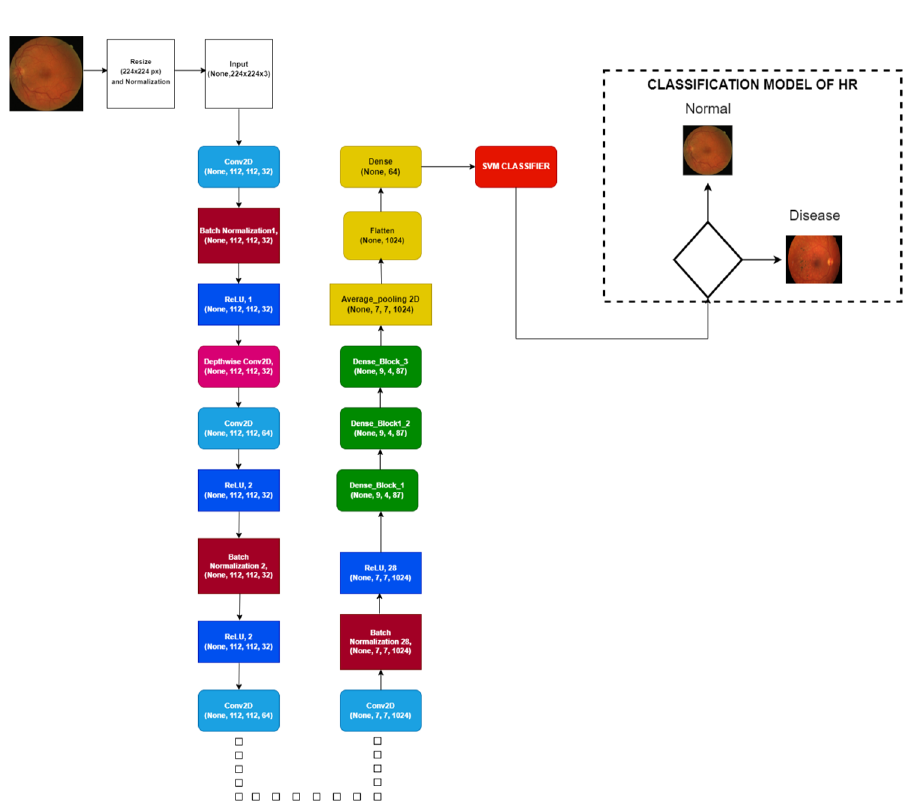
Figure 8. Complete proposed architecture of the Mobile-HR for the classification of hypertensive retinopathy.